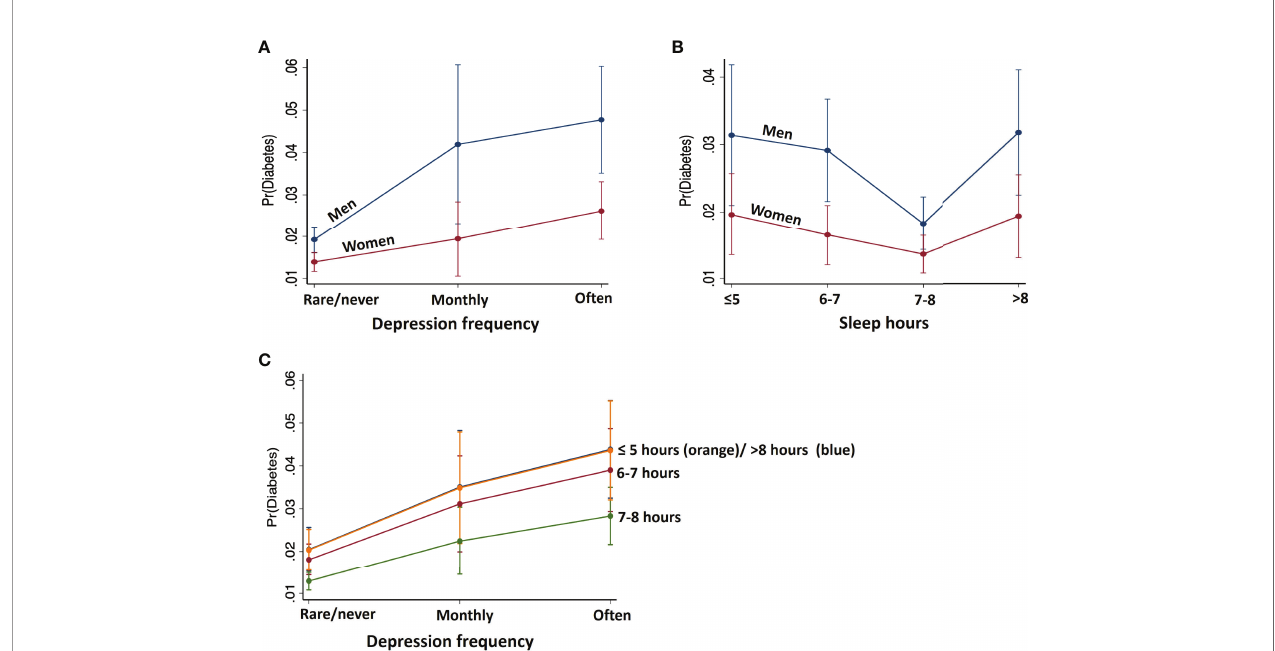
FIGURE 3 | Predicted margins of diabetes with 95% con fi dence intervals with respect to (A) depression frequency, (B) nightly sleep hours, shown separately for males and females, and (C) depression at each level of sleep. Men relative to women showed stronger associations between depression frequency and nightly sleep hours with the probability of diabetes. Further, reduced/increased sleep hours in synergy with higher frequency of depression predicts higher probability of